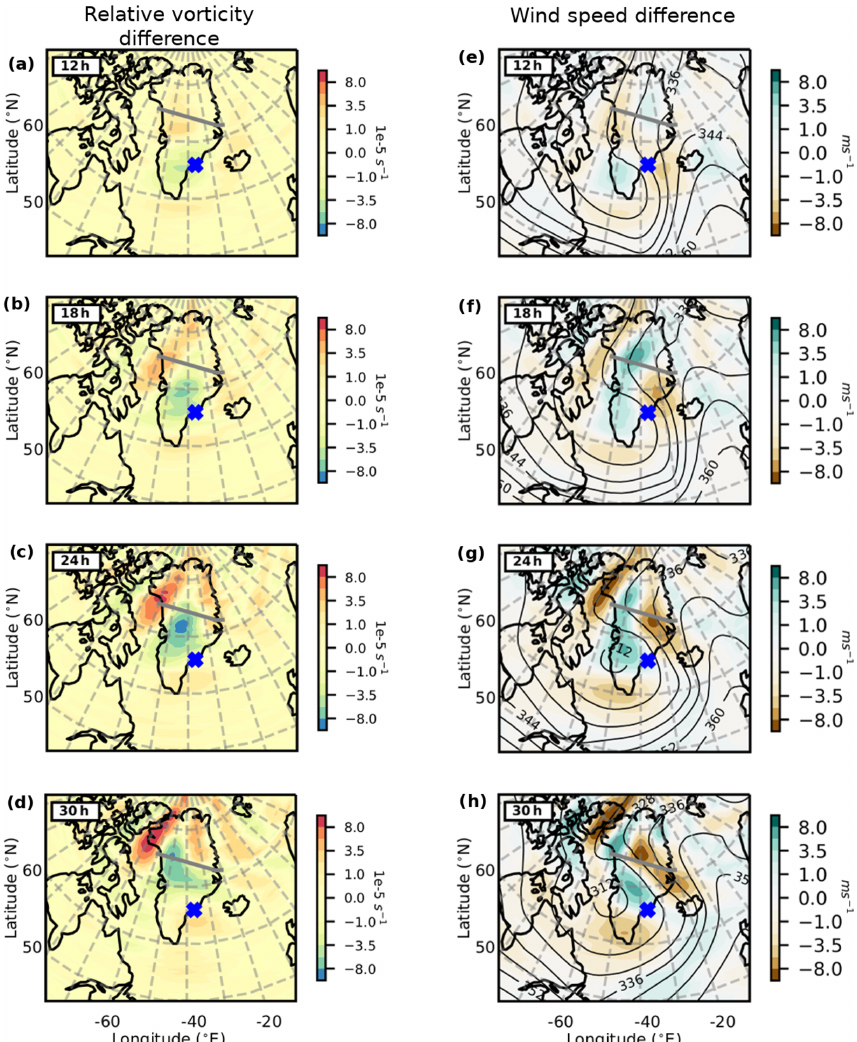
Figure 12. Difference between CTL-run and T21-run for relative vorticity (a–d) and background total wind velocity (e–h) at 8km. The revealed dipole structure is closely related to the GW excitation. The dipole structure in the wind speed difference (e–h) and the relative vorticity difference (a–d) field are offset by half a phase (90 ◦ ). Isobars (thin black line – in hPa) at the respective level are overlaid to indicate the shape of the jet. Coastline, flight path and the times indicated in the top left are similar to Fig.